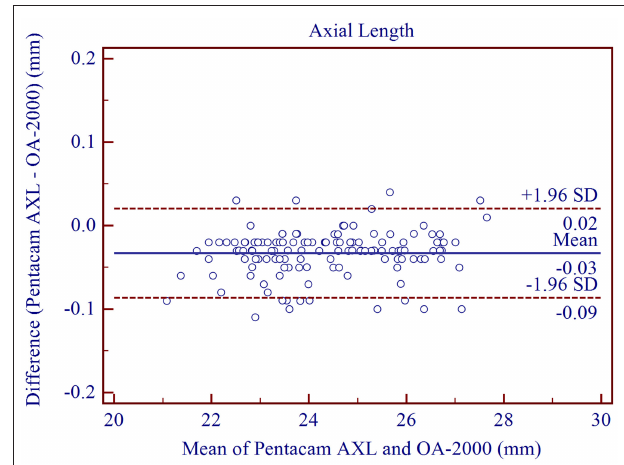
FIGURE 1 | Bland-Altman plots showing agreement between the new Scheimpflug imager in combination with partial coherence interferometry biometer and the swept-source optical coherence tomography-based biometer for measuring axial length. Solid lines represent the bias between the two devices and dotted lines represent the 95% confidence interval for the difference.